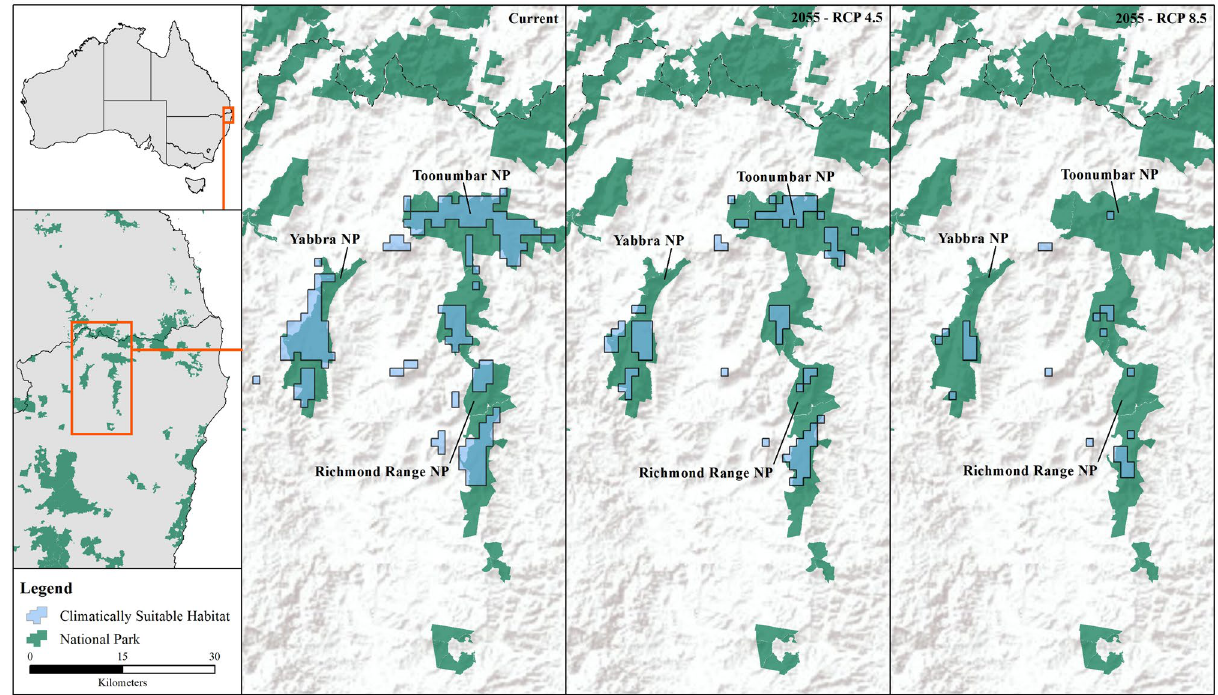
Figure 3. Predicted distribution of P. richmondensis under current conditions and, RCP4.5 and RCP8.5 climate scenarios in 2055. This figure was produced using ArcMap 10.4.1, https:// www. esri. com/ en- us/